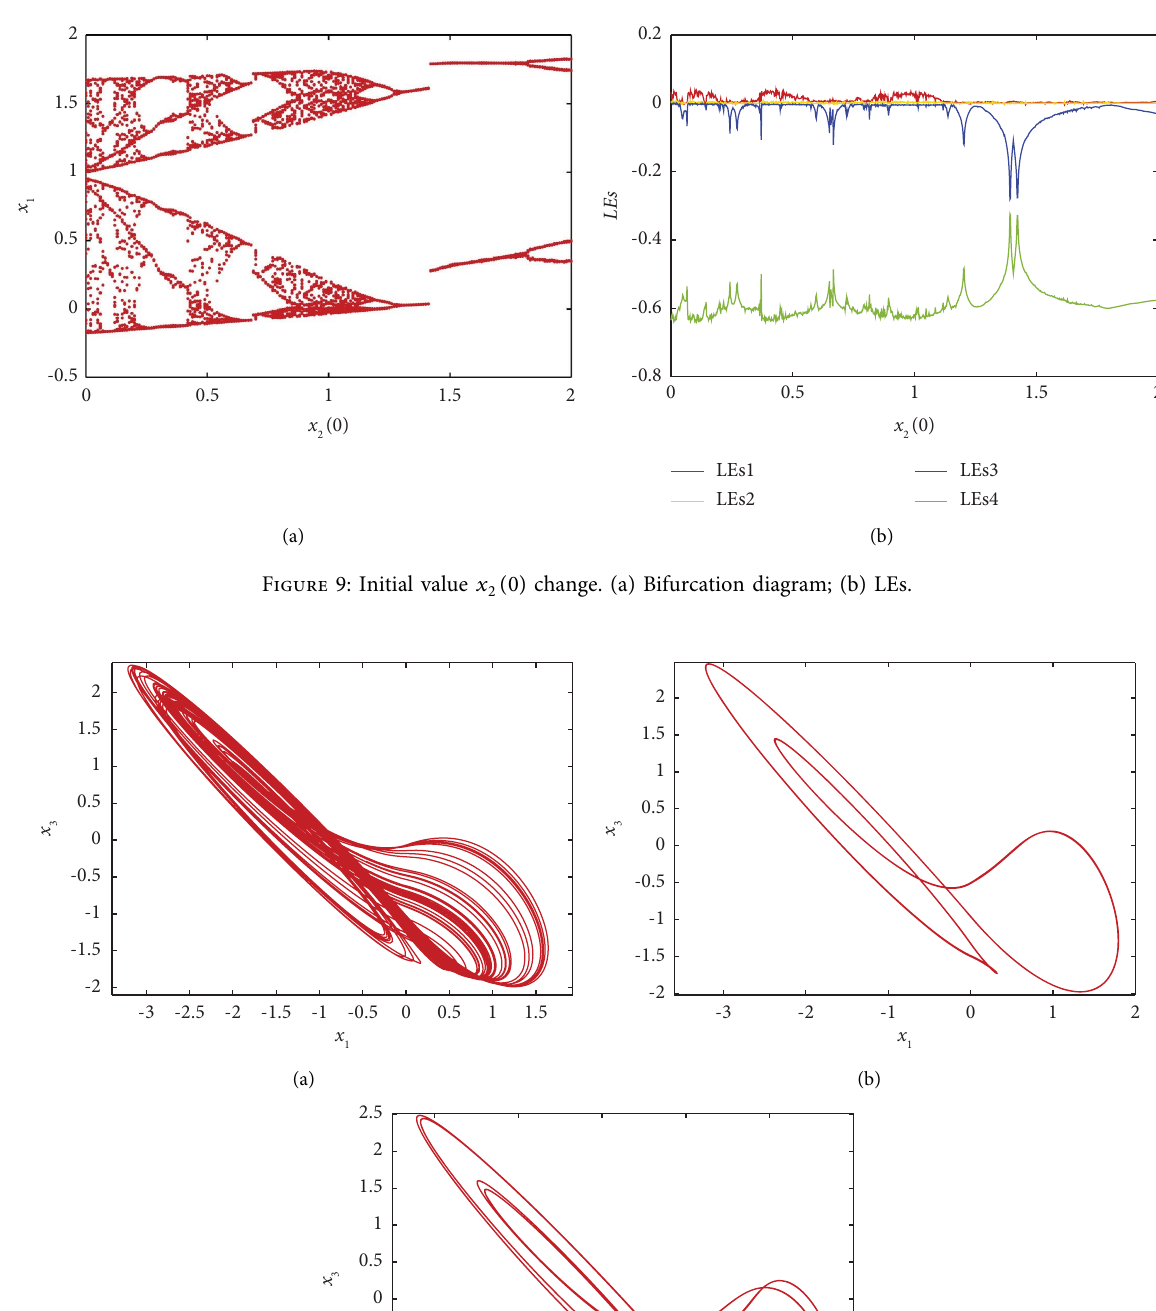
( 0 ) . (a) x ( 0 ) � 0 . 0 is x 2 2 − x plane periodic 1 3